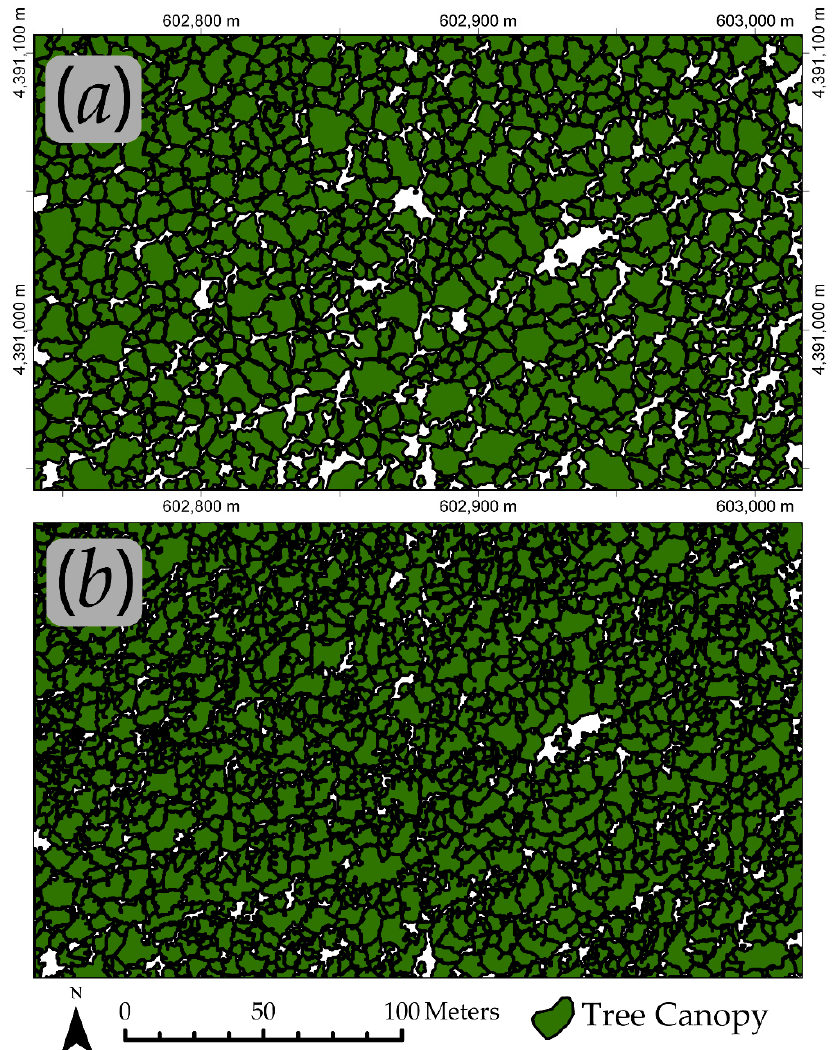
Figure 9. Assessment of individual tree crown delineation. Data are from Warner et al. [53]. The data are projected to NAD83 UTM Zone 17 North. ( a ) Reference delineation. ( b ) Minimum cost path delineation.